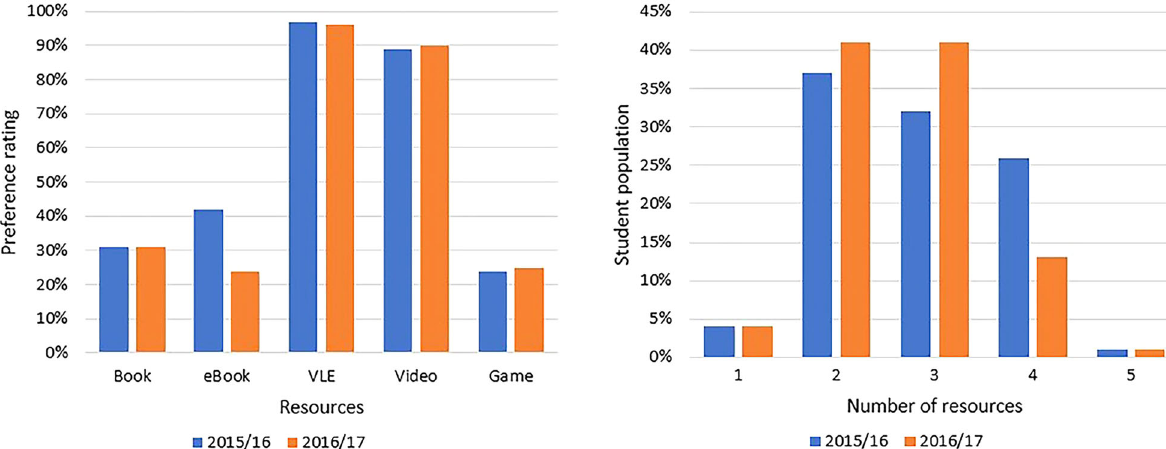
of learner support materials.